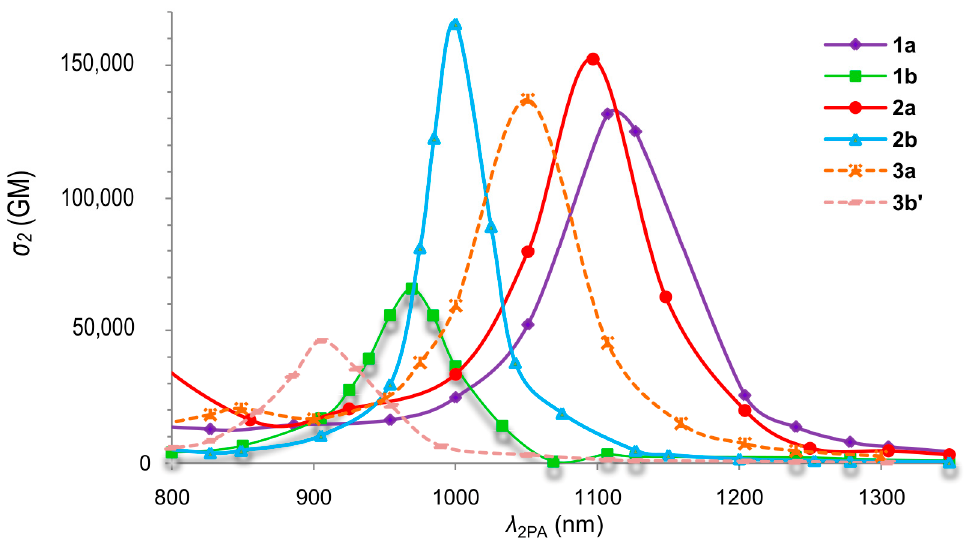
Figure 9. SAOP/DZP computed σ 2 vs. wavelength ( λ 2PA ) for the four molecules 1a , b , 2a , b and 3a , b in toluene. Table 4. Experimental and computed (for the most stable conformer a ) OPA and TPA wavelengths λ (nm), energies ω (eV) and cross-sections σ 2 (GM) of the molecules 1a , b , 2a , b and 3a,b . The OPA oscillator strengths are between